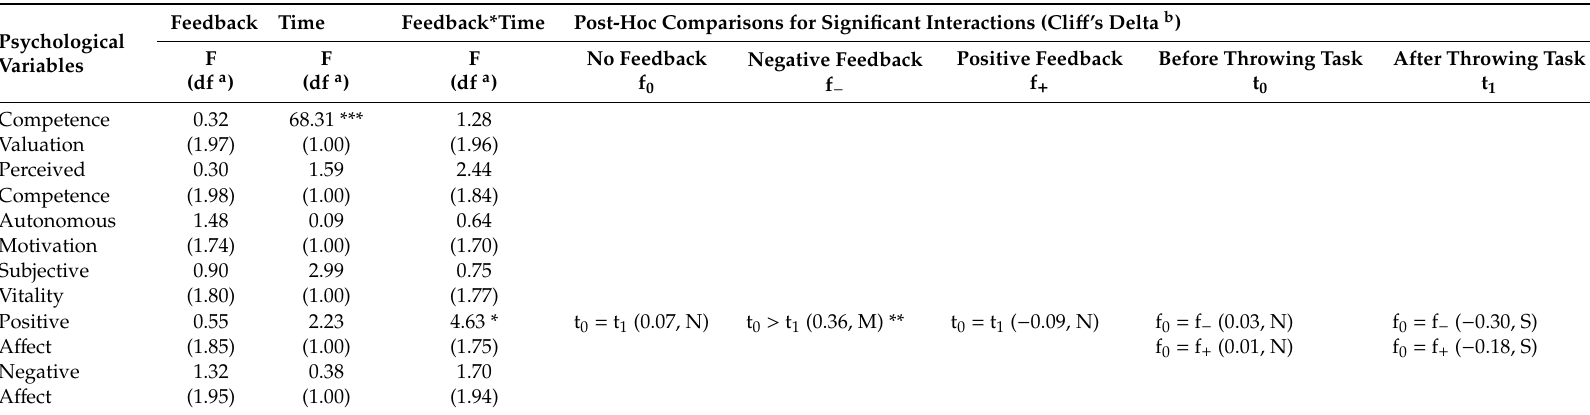
Table 3. Non-parametric repeated measures ANOVA-type models of psychological variables feedback, time of measure and their interaction, and post-hoc